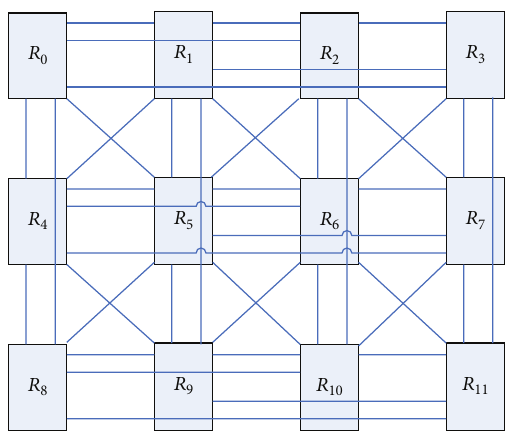
Figure 8: Expanded BFC network.